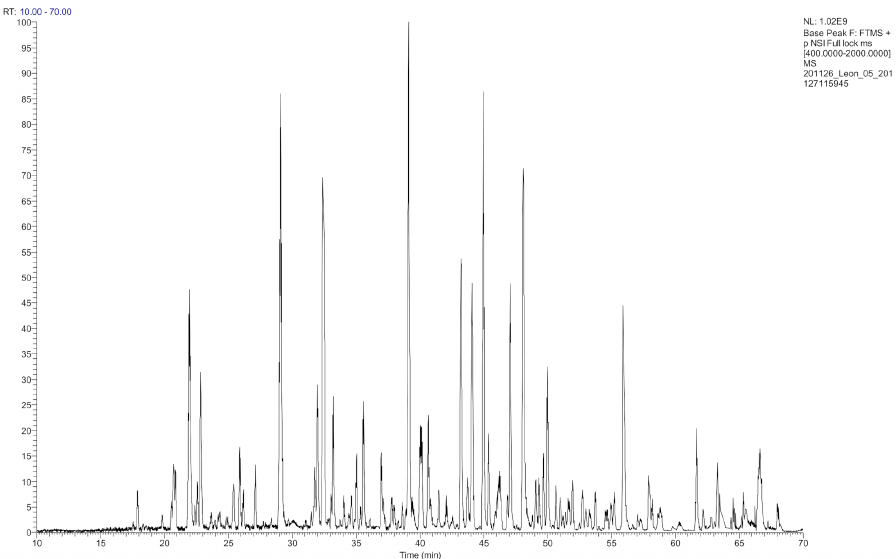
Figure 8. Base peak chromatogram of a 10 × diluted serum sample digested on HEMA-VDM paper